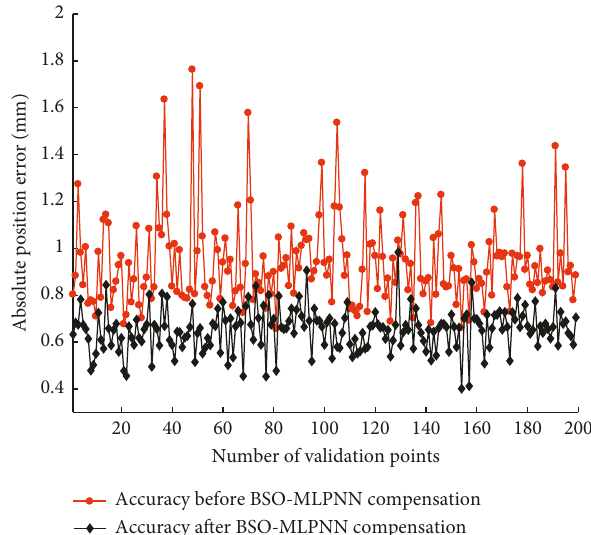
Figure 9: Absolute positioning accuracy before and after nongeometric errors compensation of validation points.